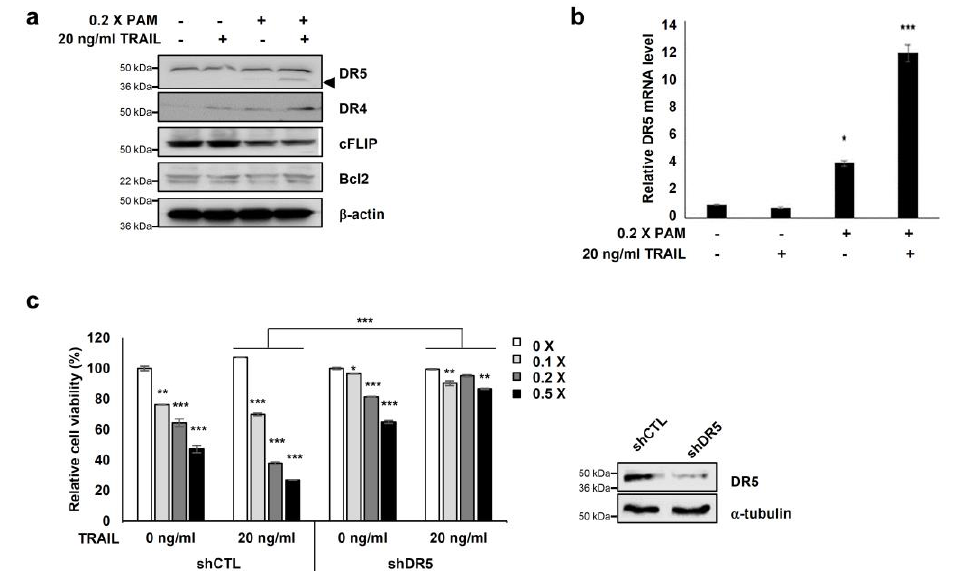
Figure 2. Co-treatment of PAM with TRAIL induces apoptosis via DR5 upregulation. ( a ) Combined treatment of PAM with TRAIL upregulates DR5 protein levels and downregulates c-FLIP protein levels in HeLa cells. Cells were treated with 0.2 × PAM, TRAIL (20 ng / mL), or PAM / TRAIL (0.2 × PAM with 20 ng / mL TRAIL). Cell extracts were prepared for immunoblotting of DR5, DR4, c-FLIP, Bcl-2, and β -actin. For immunoblotting, β -actin used as loading control. ( b ) DR5 mRNA levels were determined by qRT-PCR. GAPDH used as an internal control. ( c ) Silencing of DR5 gene was abrogated synergistic e ff ects of TRAIL to PAM-mediated cell survival inhibition. shCTL or shDR5-transfected HeLa cells were treated 0 or 20 ng / mL TRAIL with serial diluted PAM for 24 h. Cellular growth inhibition was determined via the MTT assay. * p < 0.05, ** p < 0.01, *** p < 0.001.